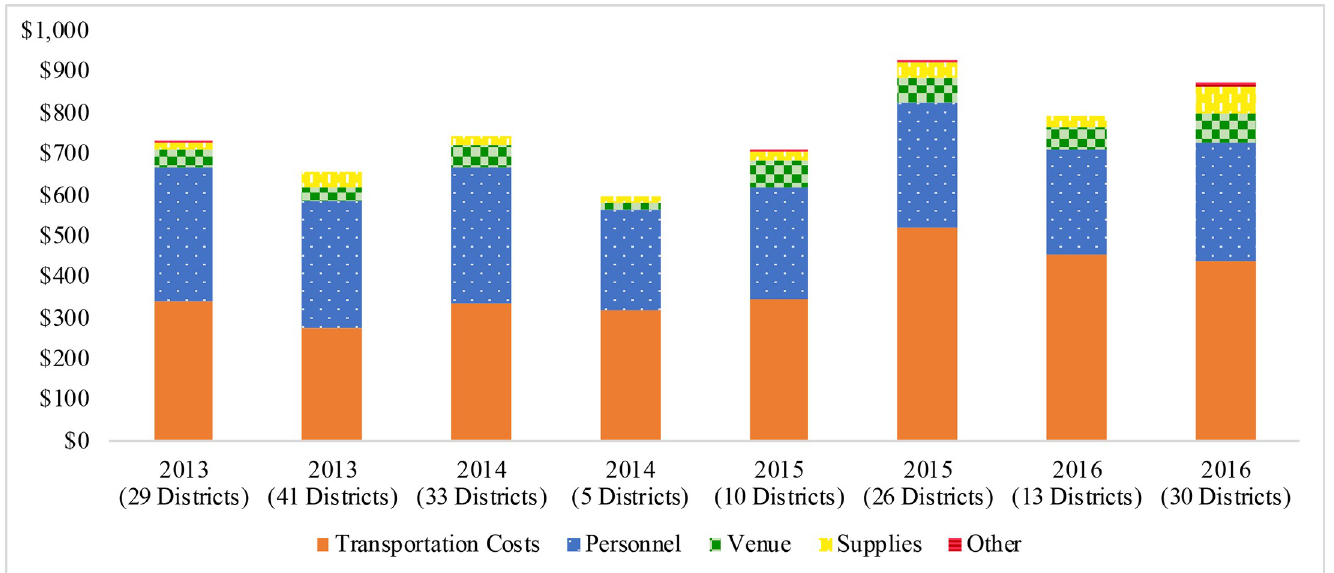
Fig 2. Per cluster costs, by input category for 8 rounds of trachoma impact and surveillance surveys, Amhara, Ethiopia, 2012–2016.